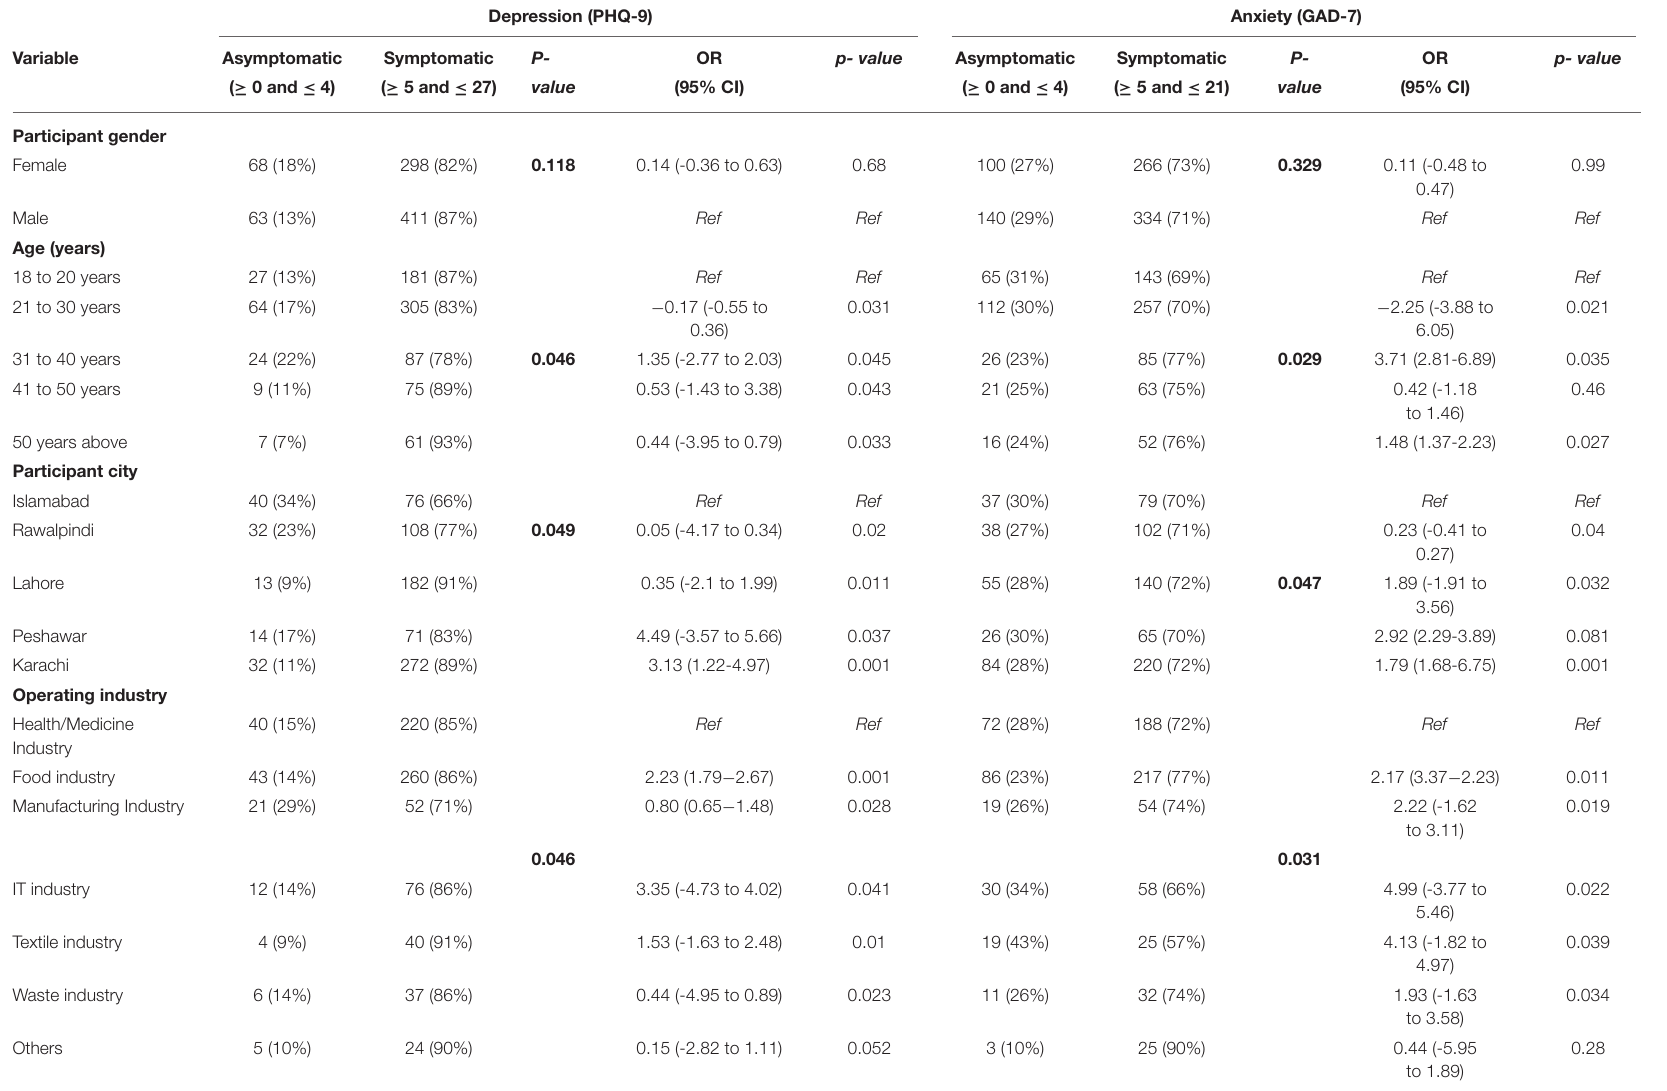
TABLE 2 | Association of demographic details with depression and